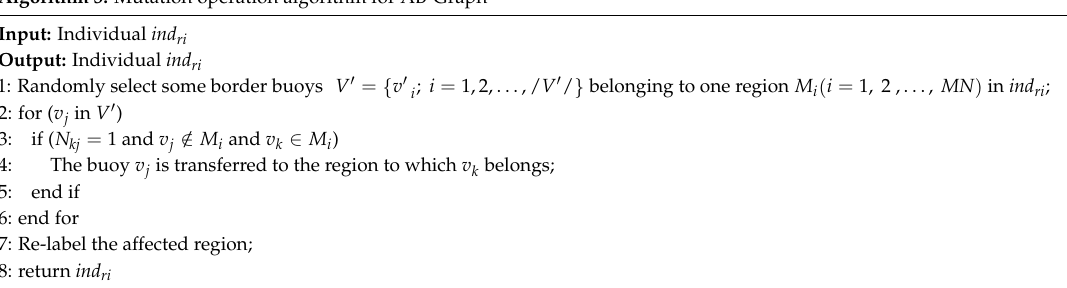
Algorithm 3: Mutation operation algorithm for